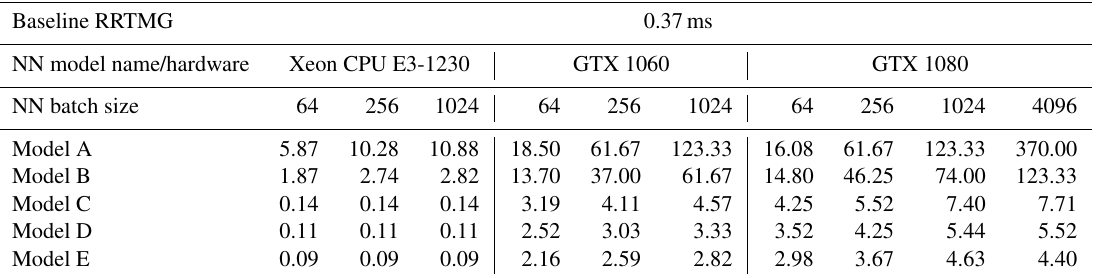
Figure 5. Models are trained with Dataset 2 and evaluated against Dataset 2 . val Table 2. Speedups when using NN models to predict RTs comparing to calculating RTs using RRTMG. The result for RRTMG is shown for the calculation of a sample in units of milliseconds. Results for NN models are shown as speedups for different batch sizes as compared to the RRTMG calculation on the Xeon